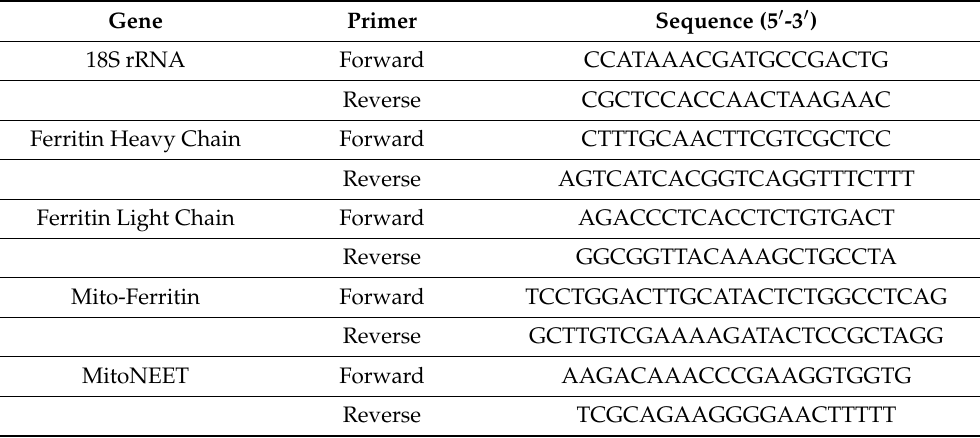
Table 1. Primer sequences used for